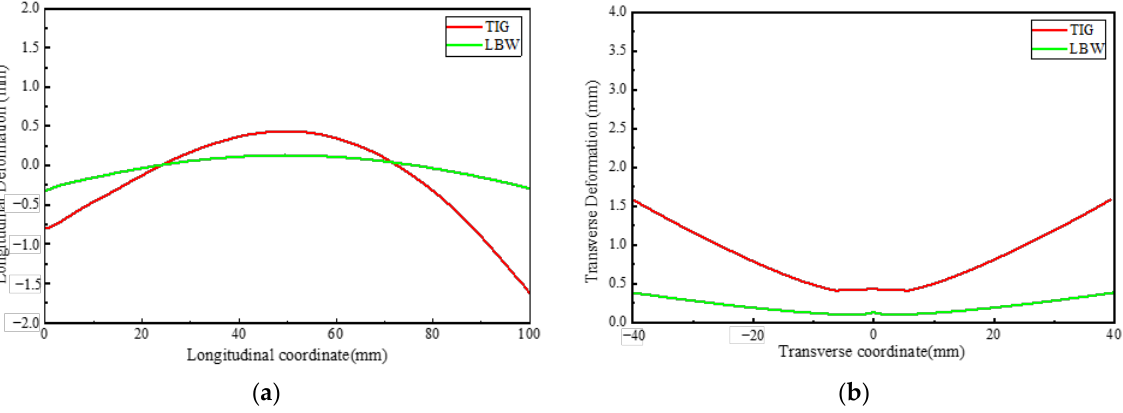
Figure 28. ( a ) Longitudinal deformation, ( b ) transverse deformation.